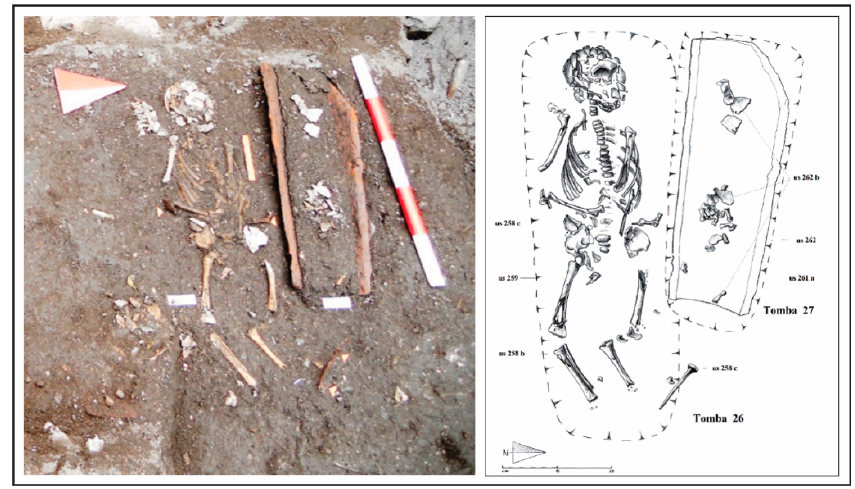
Figure 3. Photograph and plan drawing of the 0.5–1-year-old infant (grave 26) and the 21–24 weeks gestational age fetal tile burial (grave 27), from the church cemetery associated with San Biagio (photo and drawing used with the kind permission of Licata and colleagues 2019, p. 179).